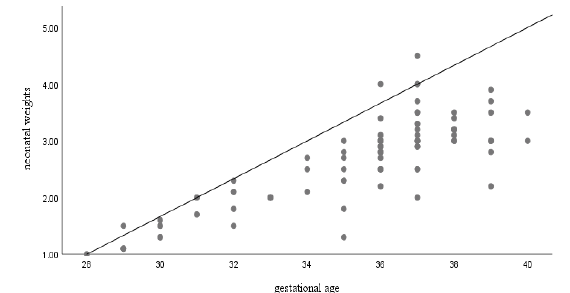
Figure 1: Correlation between gestational age and neonatal weights (r = 0.827, p value < 0.0001 ((highly significant)). Regarding vitamin D levels; the mean of maternal vitamin D level in ng/ml was (12.16 ± 7.06). 42 mothers (47.7%) had Vitamin D deficiency, 43 (48.9%) had insufficiency and 3 (3.4%) had sufficiency (Table 2).